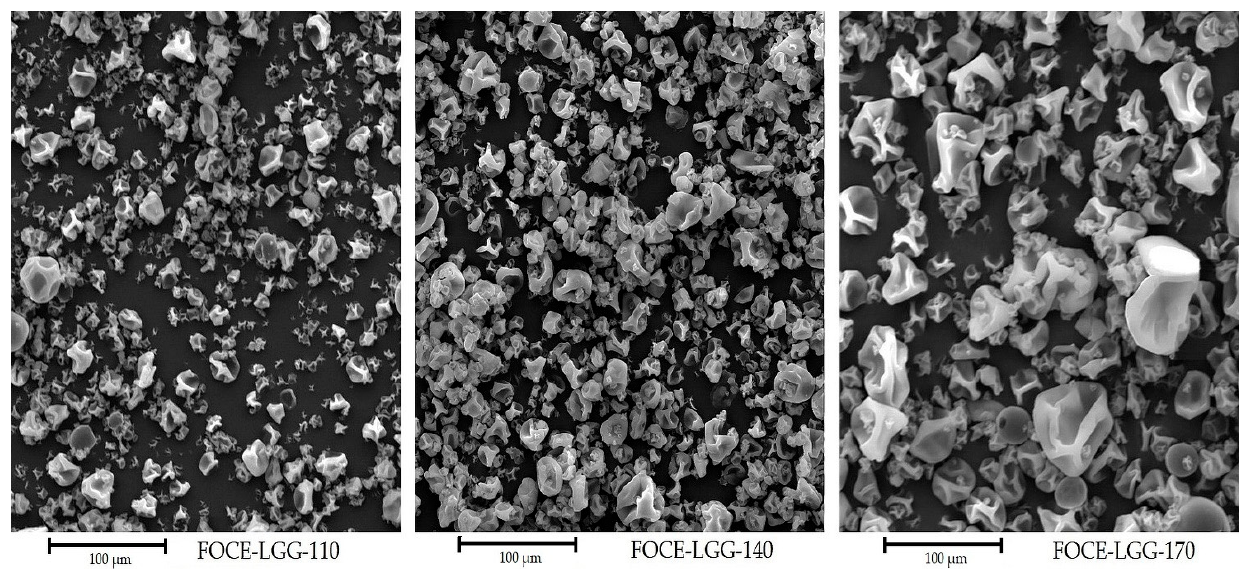
Figure 1. Morphology of FOCE-LGG spray-dried powders.